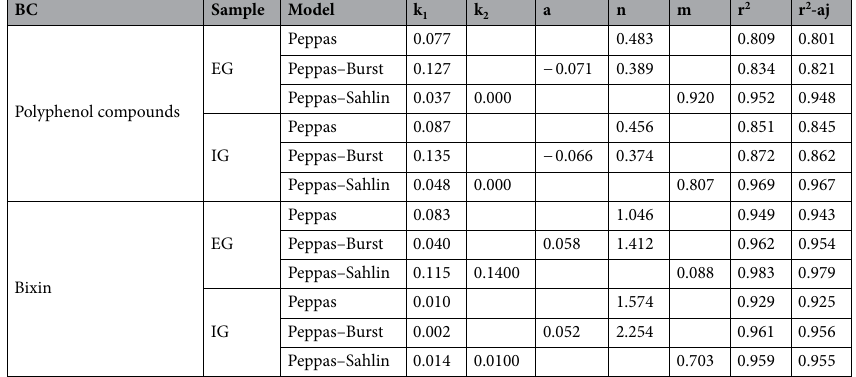
Table 3. Release parameters obtained in a sodium phosphate buffer medium (0.1 M) at a pH of 6.5 BC bioactive compounds, EG external gelation, IG internal